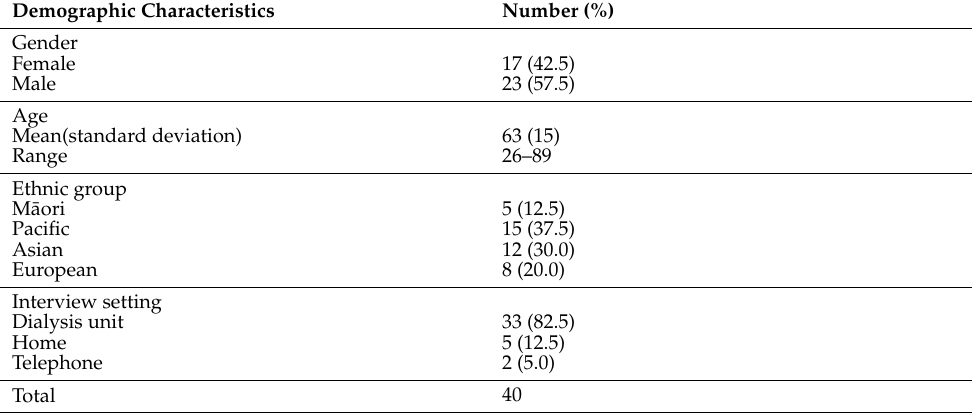
Table 1. Participant